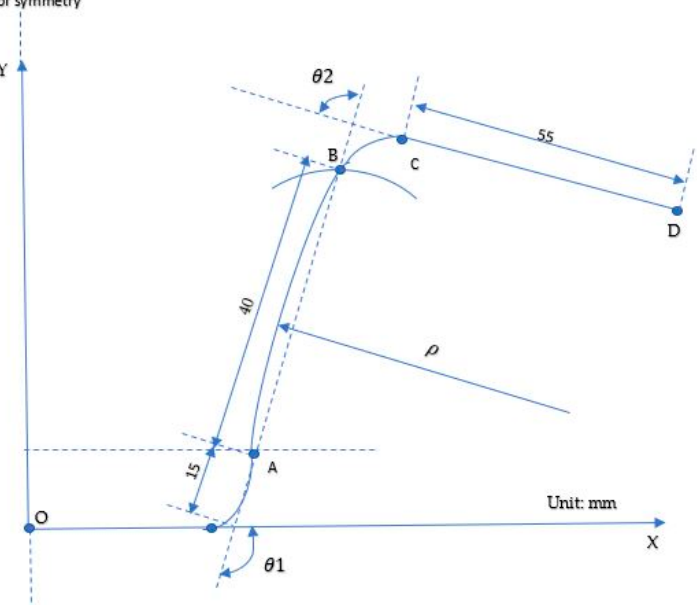
Figure 3. Parameters used for springback measurement.